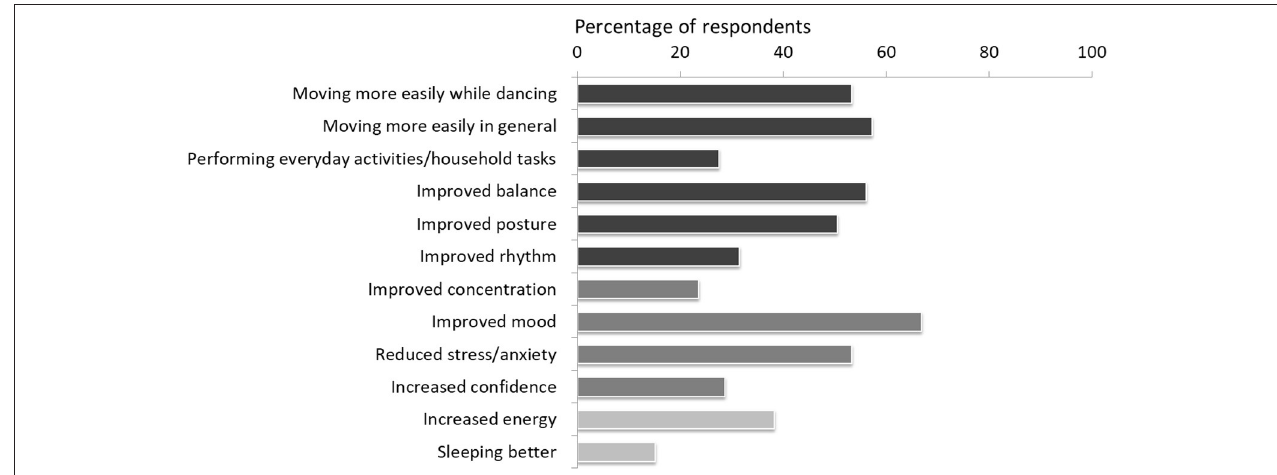
FIGURE 1 | Perceived benefits of home-based dance illustrated by percentage of participants endorsing each outcome. Sensorimotor and functional benefits are indicated by the darker bars, followed by non-motor benefits.